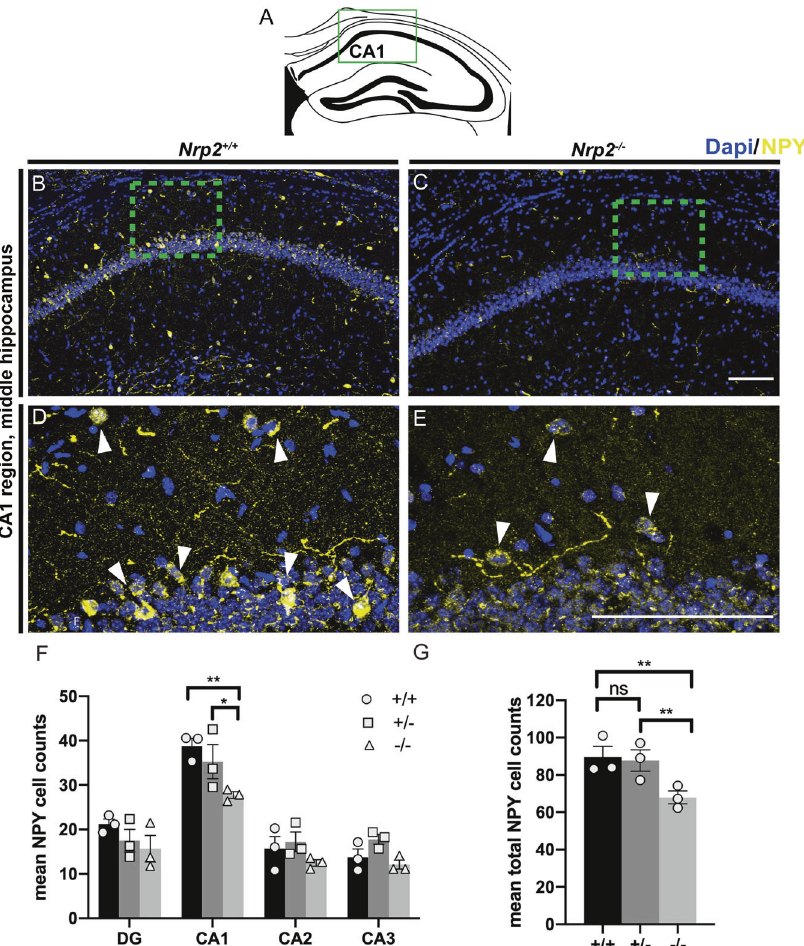
Fig. 2 Nrp2 deletion results in reduced numbers of neuropeptide Y (NPY) expressing neurons in the CA1 region. A Schematic of a coronal adult hippocampal section, green box indicates CA1 hippocampal region of images in ( B – E ). B – C Immuno-labeled Nrp2 + / + and Nrp2 − / − brain sections, respectively, with anti-NPY (yellow) and Dapi (blue). D and E High magni fi cation images of green boxes in B and C , respectively, with white arrows indicating cells. Scale bars: 100 μ m in C and E for B and D , respectively. F Quanti fi cation of the averaged number of NPY + cells by hippocampal region. Signi fi cantly more NPY + neurons found in CA1 region of Nrp2 + / + compared to Nrp2 − / − mice. Error bars are ± SEM; two- way ANOVA, post hoc Tukey: * p = 0.0474, ** p = 0.0030. G Quanti fi cation of total mean NPY + cells. Signi fi cantly fewer NPYexpressing neurons found in hippocampal region of Nrp2 − / − compared to Nrp2 + / + or Nrp2 + / − mice. Error bars are ± SEM; two-way ANOVA, post hoc Tukey: ** p = 0.0040 + / + vs. − / − , ** p = 0.0078 + / − vs. − / − , and ns p = 0.9569. In F and G: n = 3 mice compared to age-matched Nrp2 + / + littermates (Fig. 5, n = 17 cells / 4 Nrp2 + / + mice, 11 cells from 4 Nrp2 + / − mice and 13 cells from 5 Nrp2 − / − mice). Additionally, there was an increase in action potential amplitude in Nrp2 + / − and Nrp2 − / − relative to Nrp2 + / + (Fig. 5C: action potential amplitude in mV, Nrp2 + / + : 73.50 ± 2.00, n = 16 cells/4 mice; Nrp2 + / − : 83.23 ± 1.64, n = 10 cells/4 mice; Nrp2 − / − : 85.82 ± 1.58, n = 11 cells/5 mice; p = 0.001, F (1,36) = 13.167, DF = 36, One-way ANOVA). There was an apparent increase in spike frequency adaptation ratio in Nrp2 + / − and Nrp2 − / − mice, which failed to reach statistical signi fi cance (Fig. 5D: spike adaptation ratio, Nrp2 + / + : 0.52 ± 0.05, n = 16; Nrp2 + / − : 0.63 ± 0.07, n = 8; Nrp2 − / − : 0.65 ± 0.06 mV, n = 13; p = 0.193, One-way ANOVA). Examination of passive properties revealed that the resting membrane potential in pyramidal cells from mice lacking Nrp2 was hyperpolarized relative to Nrp2 + / + mice (Fig. 5E: resting membrane potential in mV, Nrp2 + / + : − 61.12 ± − 0.82, n = 17; Nrp2 + / − : − 65.40 ± − 1.25, n = 11; Nrp2 − / − : − 64.57 ± – 0.75, n = 13; 0.004, F = 16.388, DF = 40, One-way ANOVA). However, the input resistance was not different between groups (Fig. 5F: R in in M Ω , Nrp2 + / + : 203.23 ± 16.73, n = 17; Nrp2 + / − : 178.63 ± 12.94, n = 11; Nrp2 − / − : 174.74 ± 12.23, n = 13; p = 0.481, h = 1.462 with 2 DF, ANOVA on Ranks). Similarly, the